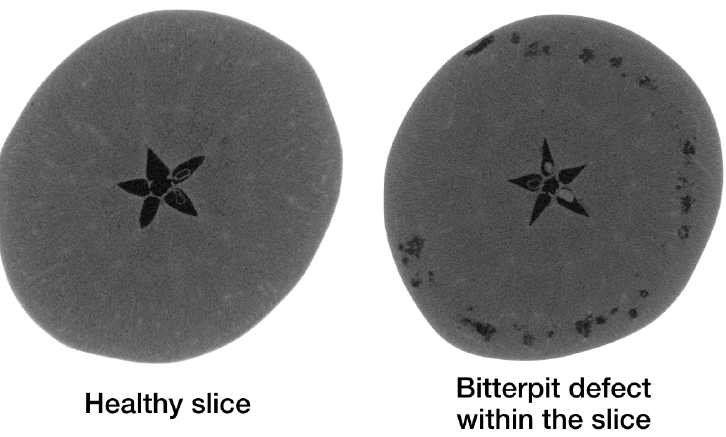
Figure 3. A horizontal cross-section of a healthy slice in an apple is shown on the left , and another cross-section with the bitter pit defects in the same apple on the right